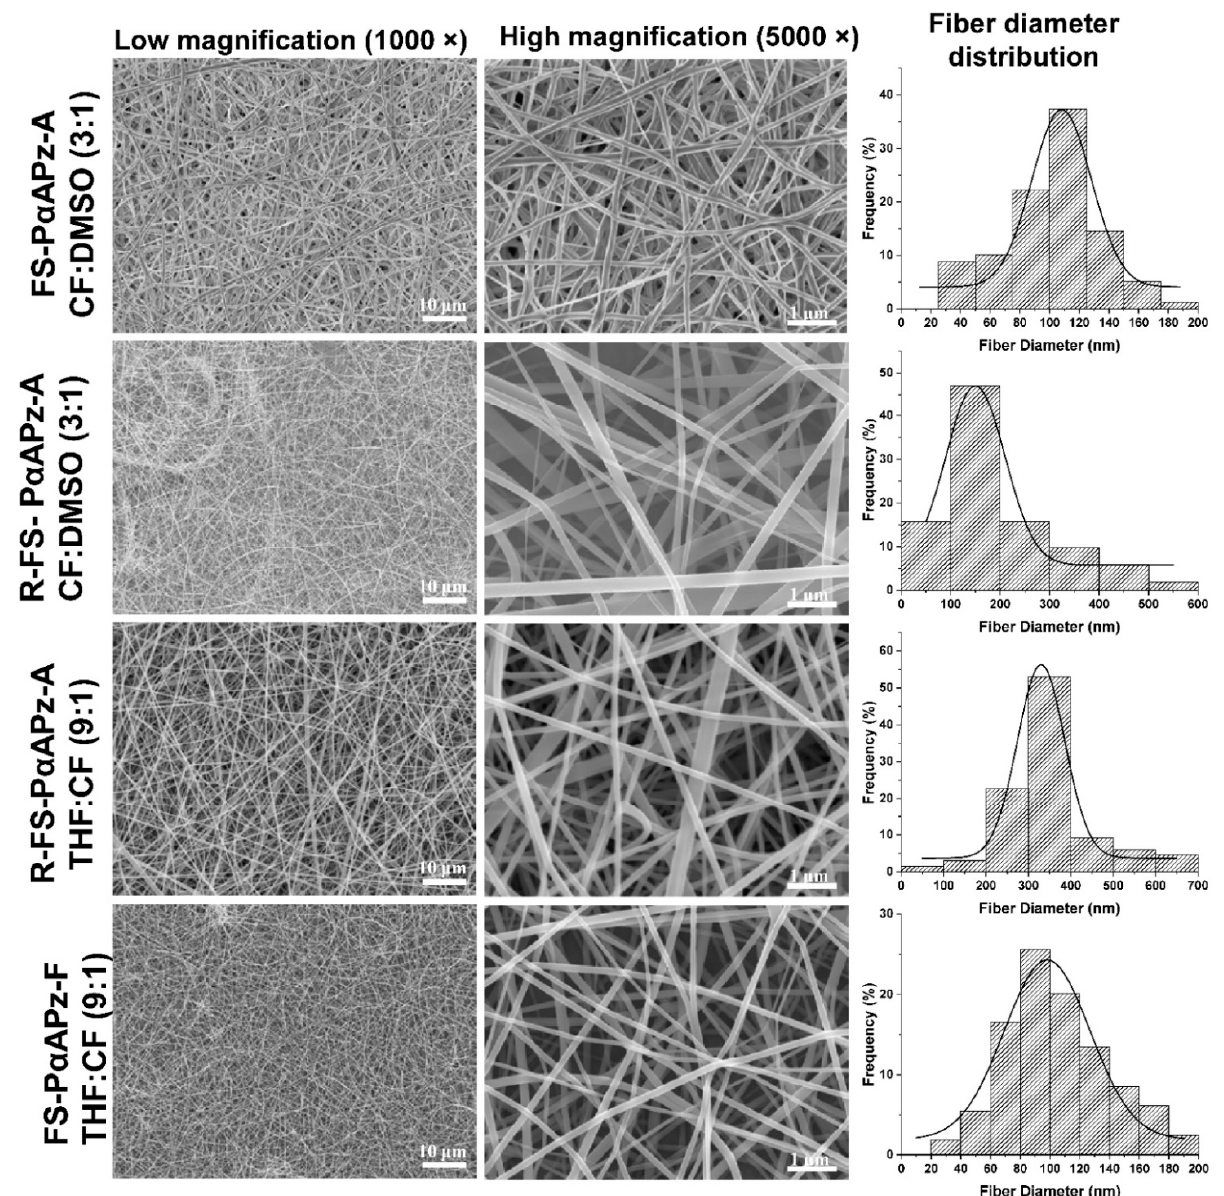
Figure 2. SEM images of electrospun P α APz derived from L-phenylalanine and L-alanine, as well as the corresponding histogram, showing the fiber diameter distribution. For each SEM image, the PDCP synthesis method (FS—flame sealing; R-FS: recrystallization followed by flame sealing) and the optimum solvent ratio are shown. Other electrospinning parameters are listed in Table 3.